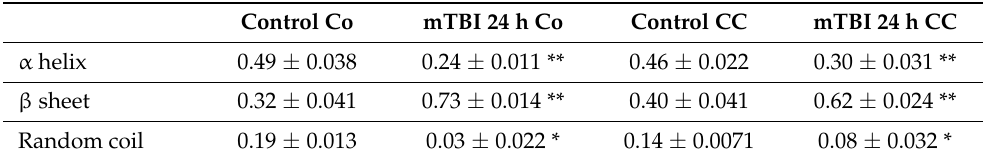
Table 3. Relative amounts of the secondary structural protein contents were quantified from the curve fitting of original absorbance spectra of amide I